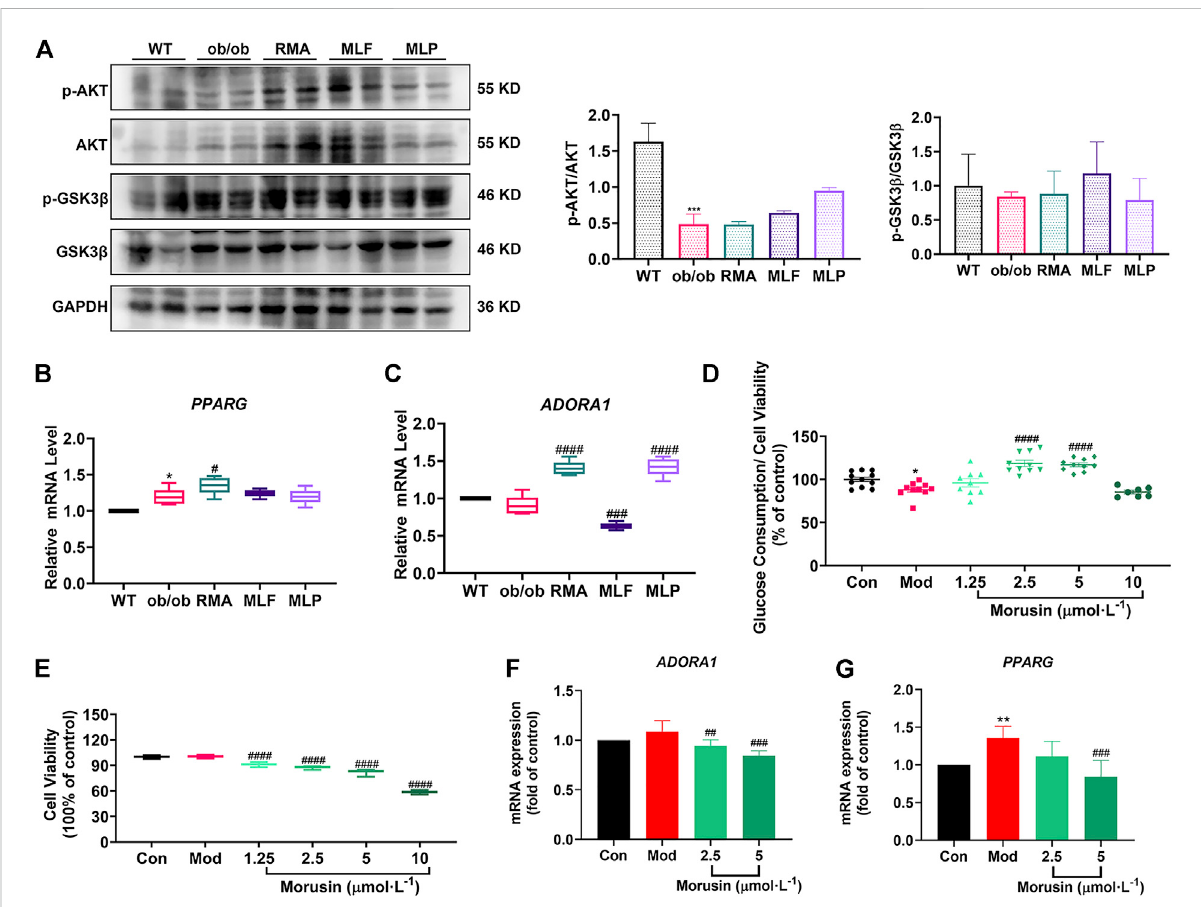
FIGURE 10 Validationofkeytargetsinob/obmiceandinsulin-resistantL02cells. (A) Proteinlevelsofp-AKT,AKT,p-GSK3 β andGSK3 β intheliversofob/ob mice. mRNA levels of PPARG (B) and ADORA1 (C) in the livers of ob/ob mice. * p < 0.05, *** p < 0.001, compared with WT group; # p < 0.05, ### p < 0.001, #### p < 0.0001, compared with the ob/ob group. Glucose consumption (D) and cell viability (E) were determined following treatment with different concentrations of morusin in L02 cells. RT ‒ qPCR analysis of mRNA levels of ADORA1 (F) and PPARG (G) in insulin ‒ resistant L02 cells stimulated with morusin for 24 h * p < 0.05, ** p < 0.01, compared with Con group; ## p < 0.01, ### p < 0.001, #### p < 0.0001, compared with Mod